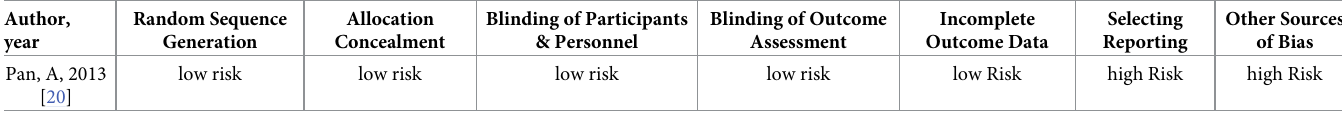
Table 4. Cochrane Risk of Bias Tool of included clinical